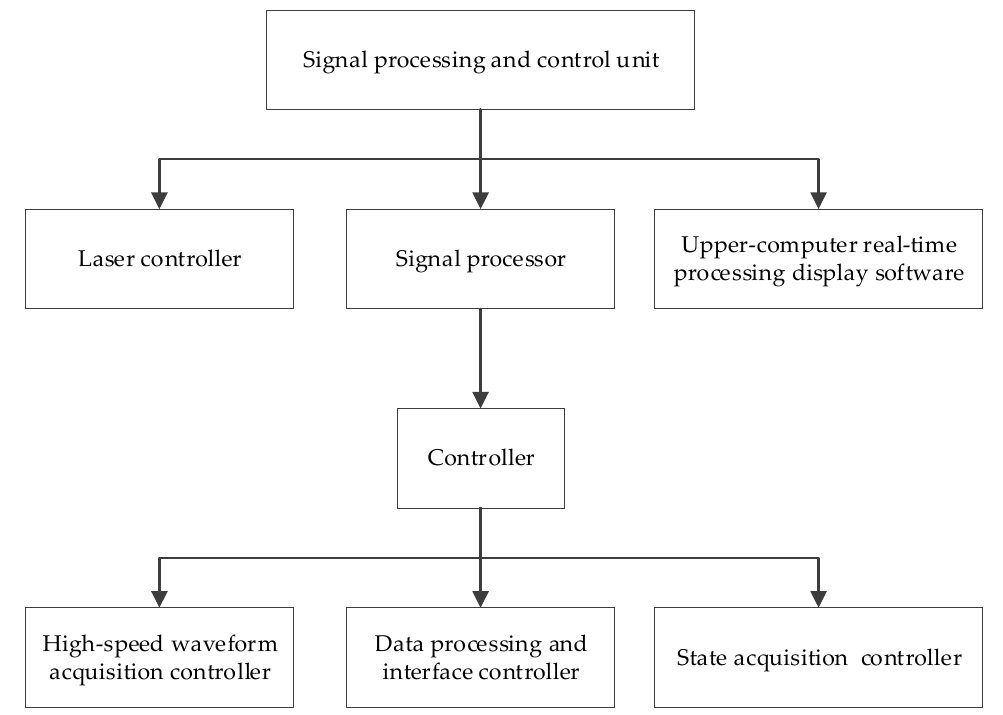
Figure 3. Signal processing and control unit structure.